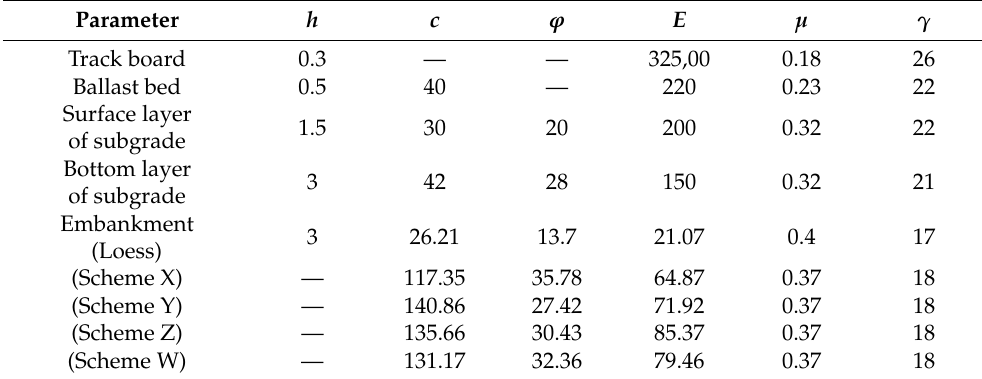
Table 8. Calculation parameters of the finite element model.